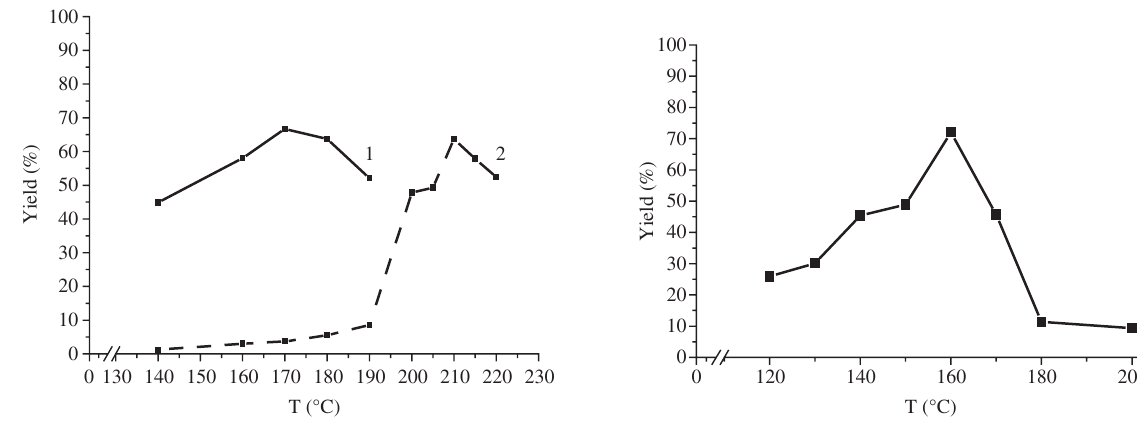
Figure 3: Temperature dependence for the α -naphthol conversion into 1-hydroxy-2-naphthoic acid by carboxylation in an air medium = 1.2 atm, τ = 7 (P air